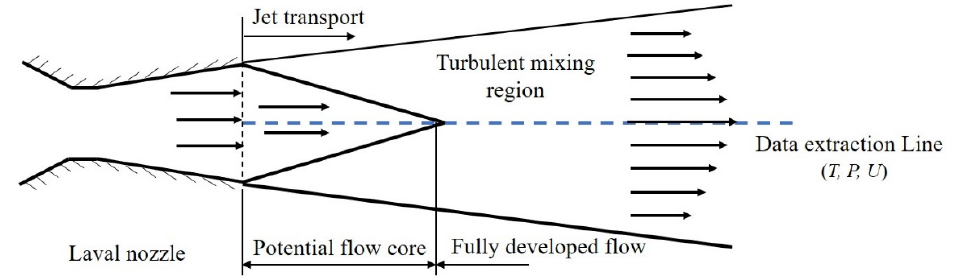
Figure 8. Illustration of the supersonic jet transport.